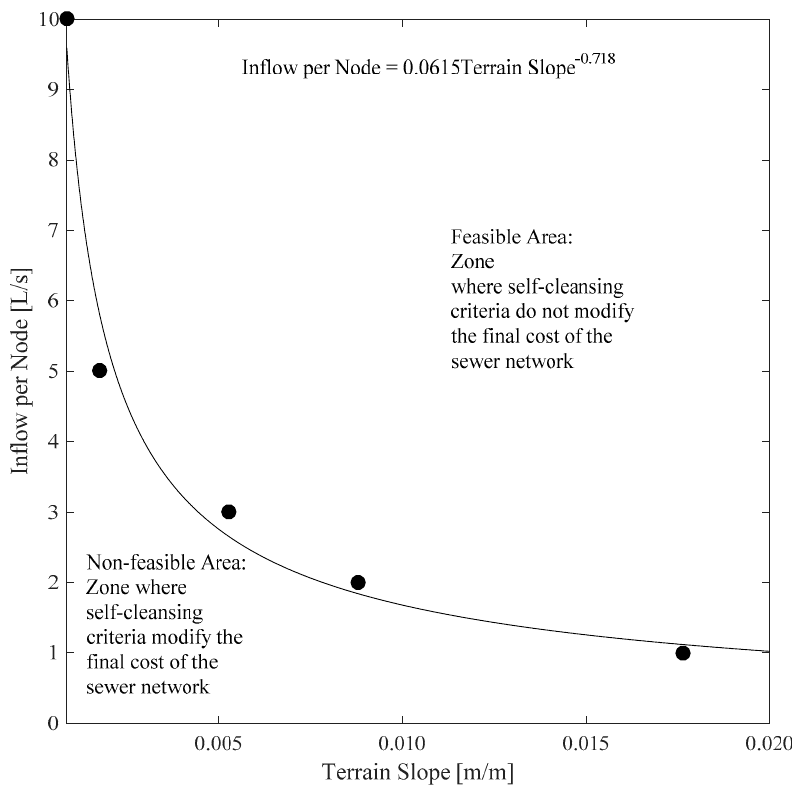
Figure 3. Network costs for the five wastewater proposed simulations: ( A ) Simulation 1 (Inflow per node 1 L/s), ( B ) Simulation 2 (Inflow per node 2 L/s), ( C ) Simulation 3 (Inflow per node 3 L/s), ( D ) Simulation 4 (Inflow per node 5 L/s), and ( E ) Simulation 5 (Inflow per node 10 L/s). Cost in (USD).